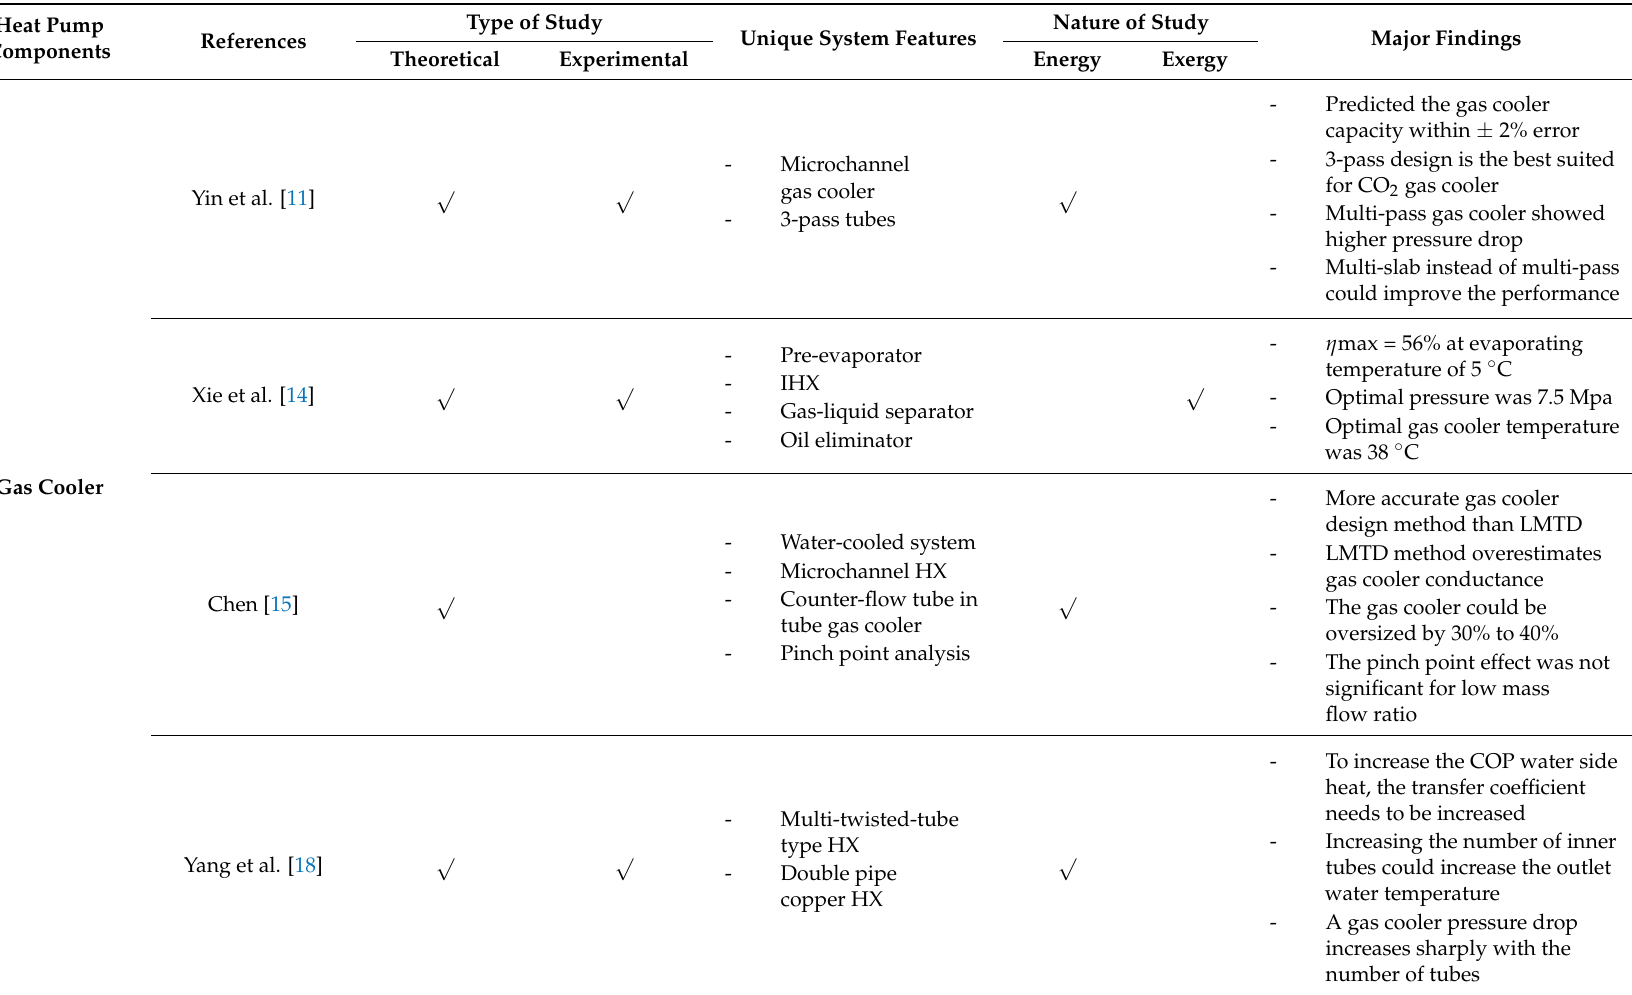
Table 2. Recent significant studies on CO 2 heat pump system